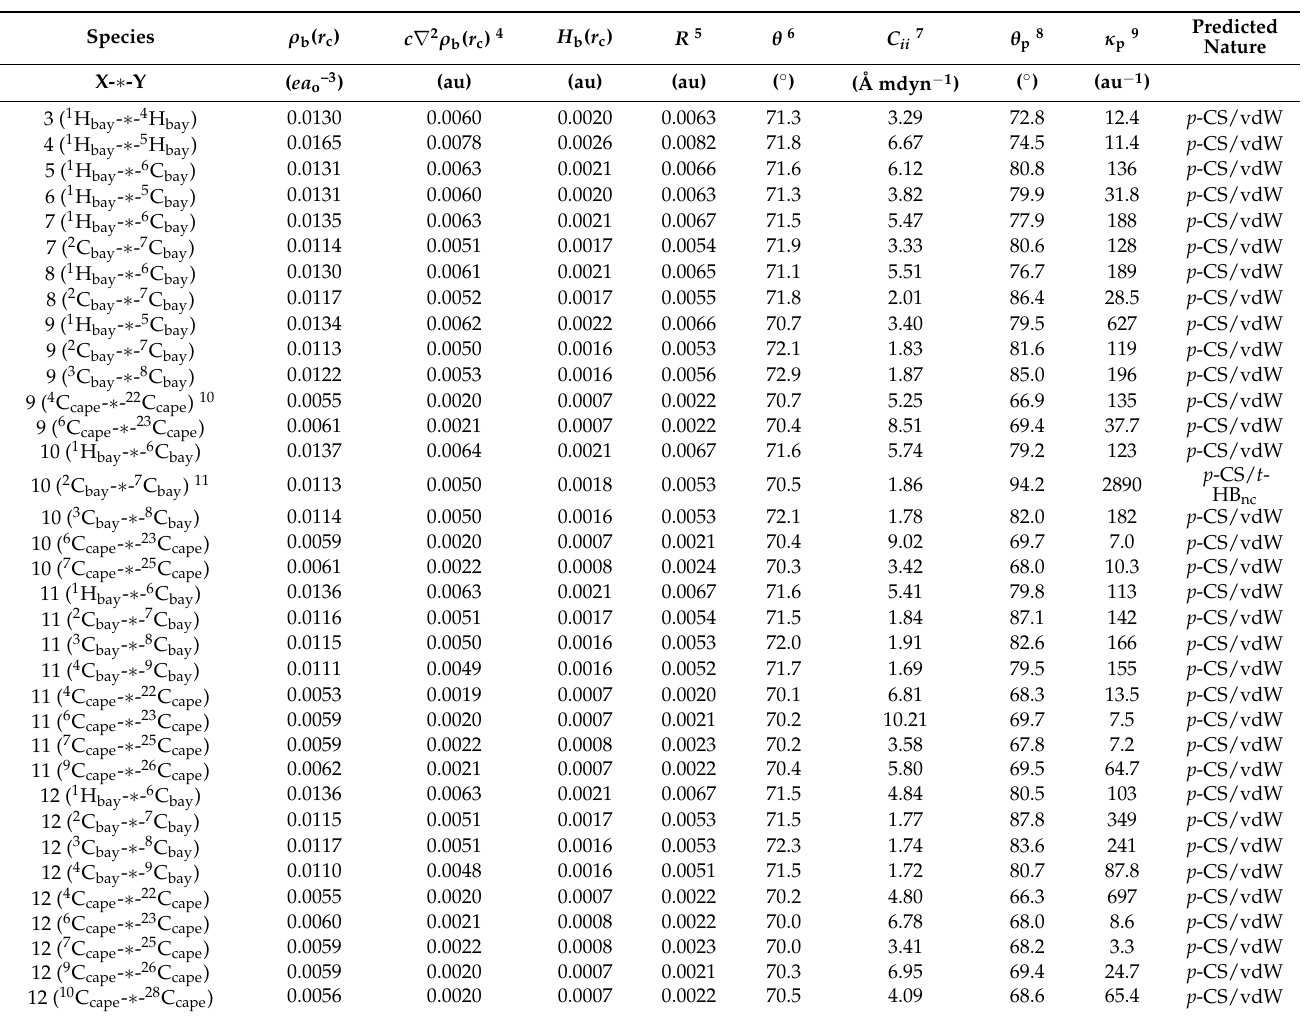
Table 1. QTAIM Functions and QTAIM-DFA Parameters Evaluated for the Fused Benzene-Type Helicenes of Monomers ( 3 – 12 ), Employing the Perturbed Structures Generated with CIV 1–3